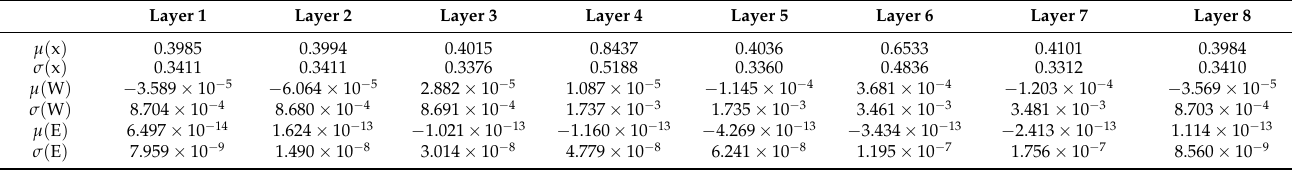
Table 1. Mean and variance of convolutional layer inputs ( x ), weights ( W ), and back propagated errors ( E ) from the first training iteration in a downsized VGG network. Note all these mean and variance values are calculated from all x , W , E in each layer. The CIFAR-10 dataset was used, and the network contained eight convolutional layers. All mean and variance values for the weights and errors are extremely small, which enables the sine approximation of the original